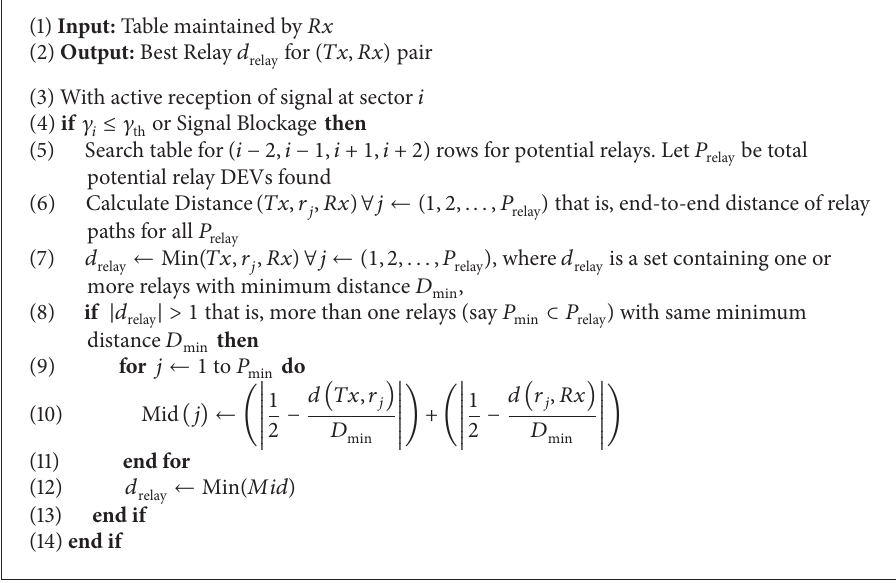
Algorithm 2: Distributed receiver based intragroup relay